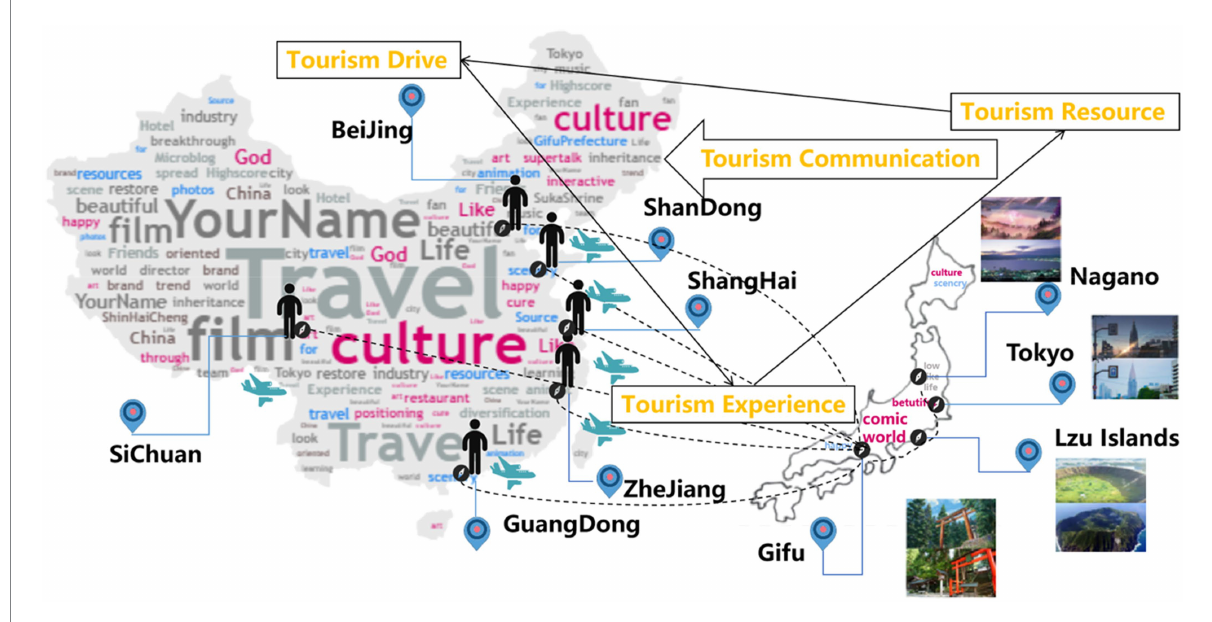
FIGURE 2 Cultural empowerment tourism of Your Name : based on interest-related